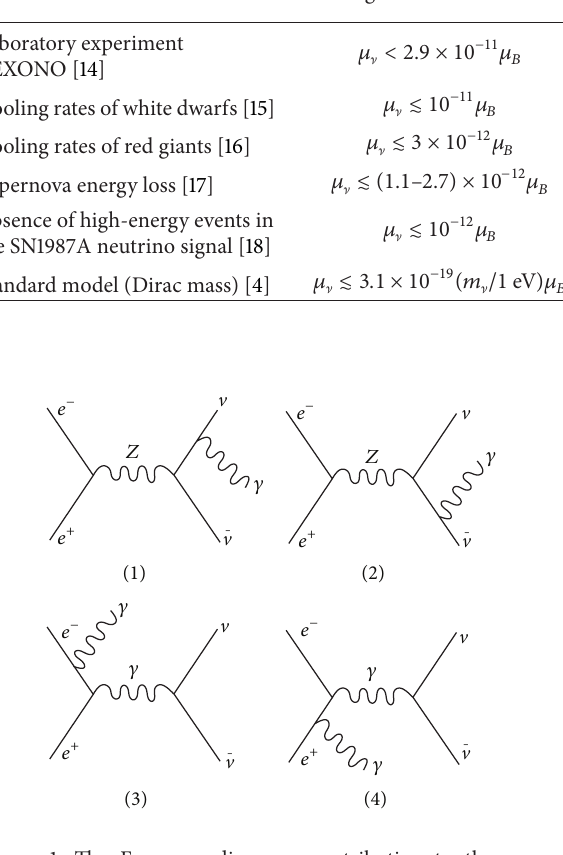
Figure 1: The Feynman diagrams contributing to the process 𝑒 + 𝑒 − → ]] 𝛾 (1, 2) when the 𝑍 vector boson is produced on mass-shell and (3, 4) contributions from anomalous neutrino electromagnetic couplings with initial-state